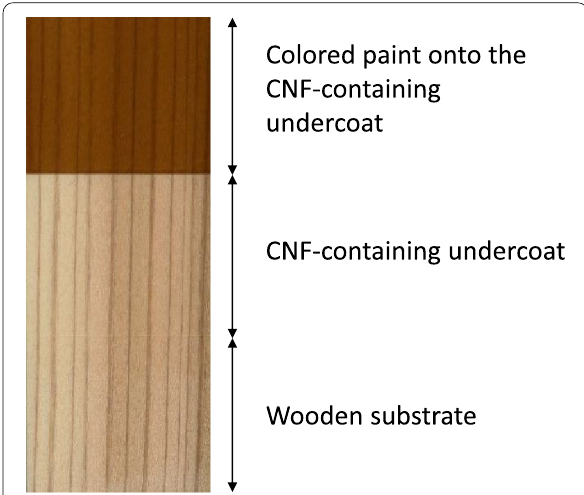
Fig. 1 Appearance of painted wooden board using CNF-containing undercoat. Cryptomeria japonica was used as a wooden